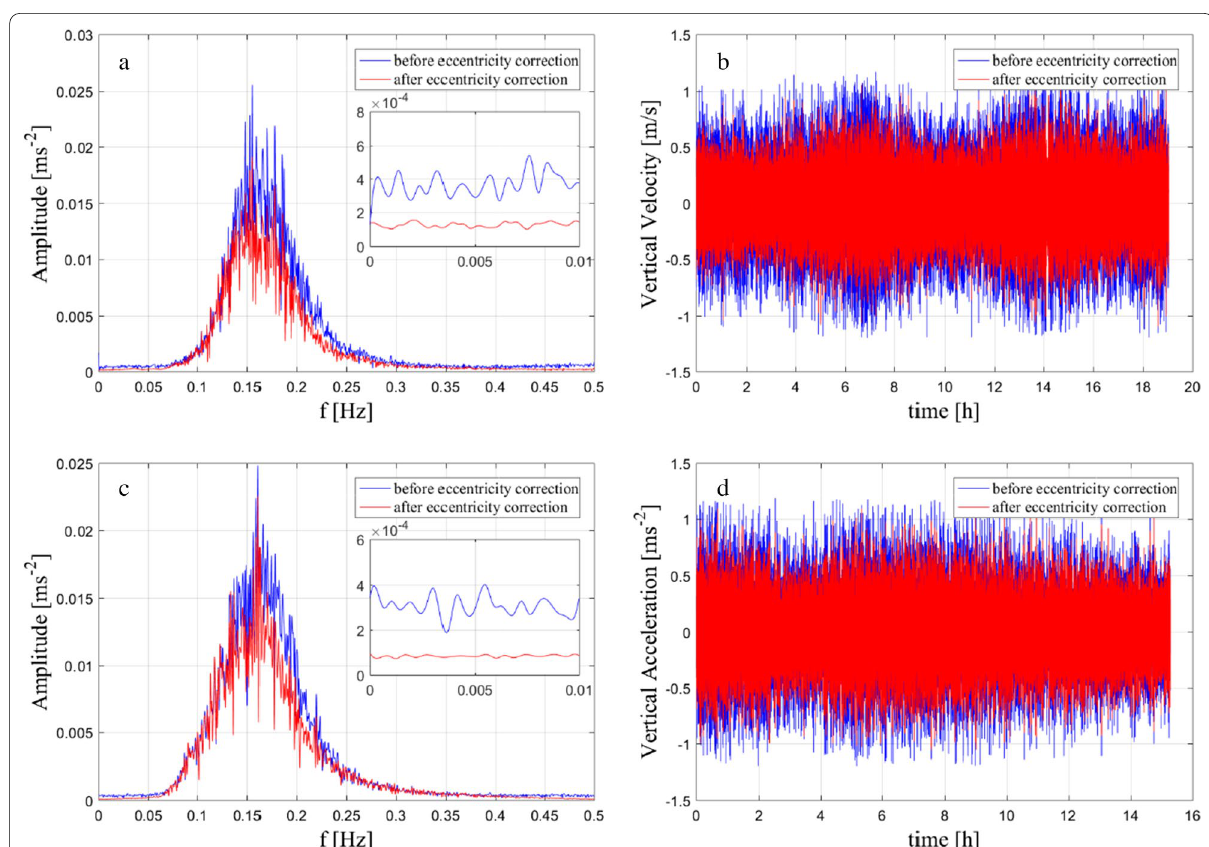
Fig. 15 Fourier time–frequency analysis of vertical accelerations. a and c are the single-sided amplitude spectra of the vertical acceleration of X1-3 and H1-1, respectively; the small windows are enlarged views of the low-frequency band. b and d are the corresponding time-domain vertical accelerations